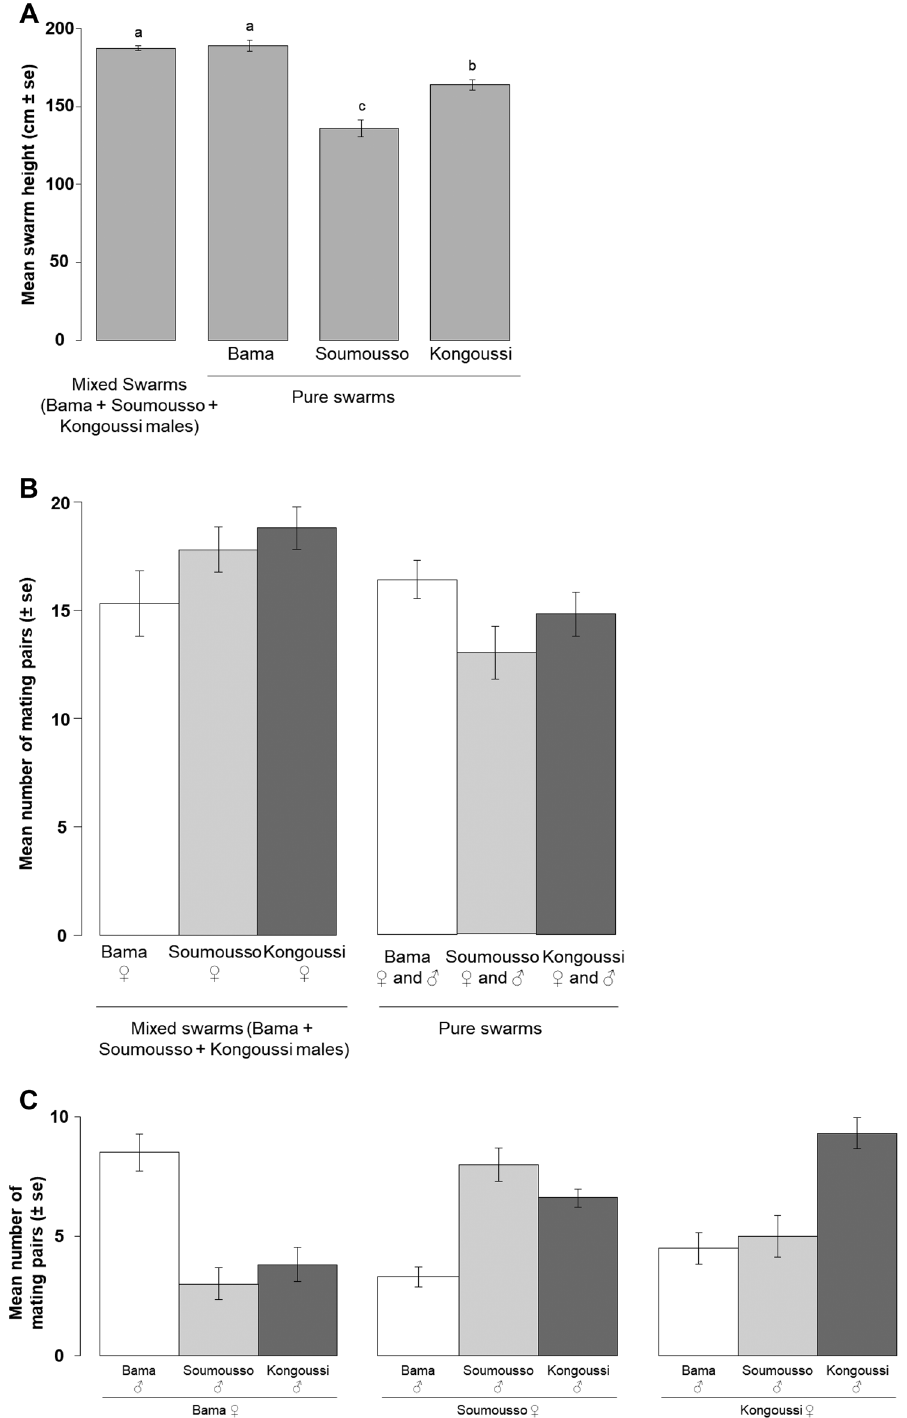
Figure 3. Swarm characteristics and male competitiveness in three wild populations (Experiment 3). ( A ) Mean swarm height in each population and in mixed swarms; ( B ) Mean number of mating pairs produced in both pure and mixed swarms with females of the three populations; ( C ) Observation of assortative mating through the mean number of mating pairs obtained in mixed swarms with females of each population. SE: standard errors. Different letters above bars show statistical significance for multiple comparisons at P <